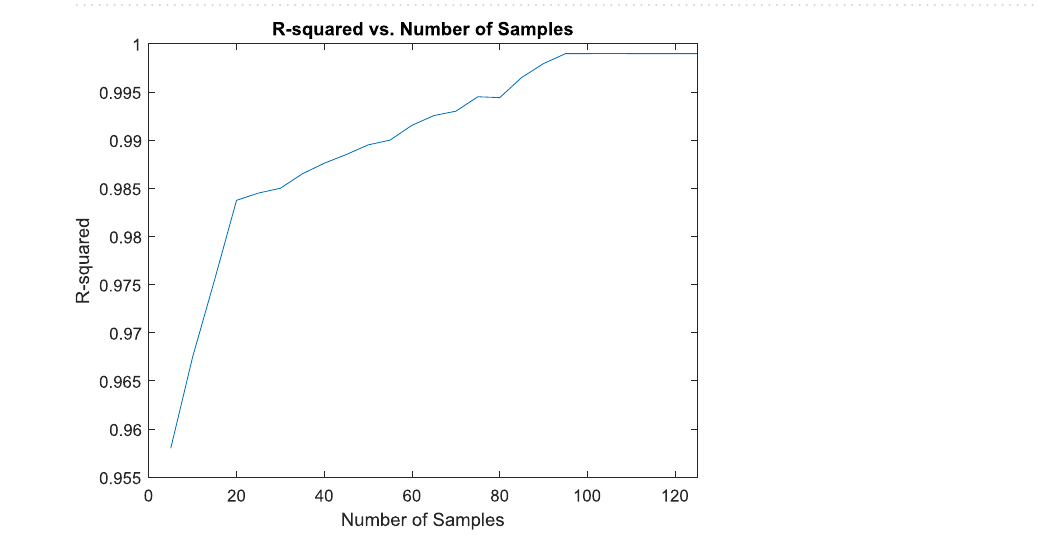
Figure 6. Change in network performance with the number of synthetic